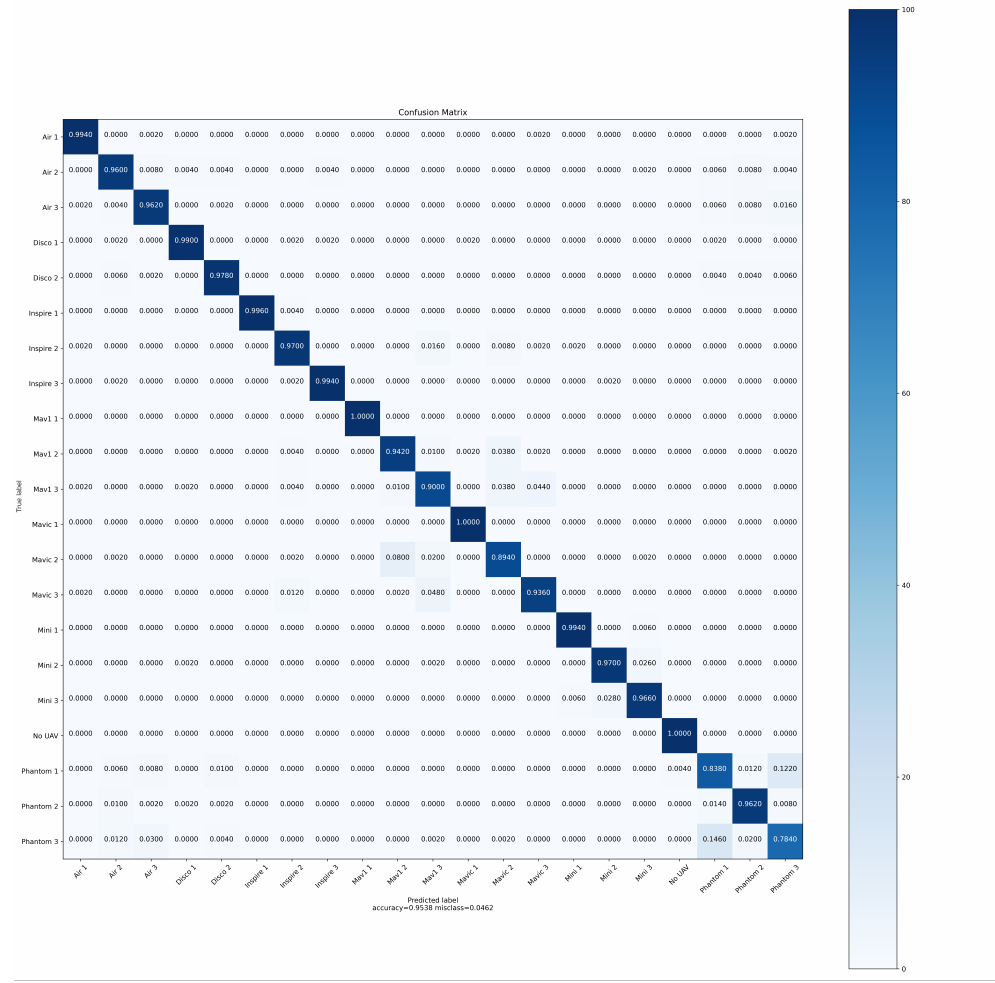
Figure 15. UAS flight mode classification confusion